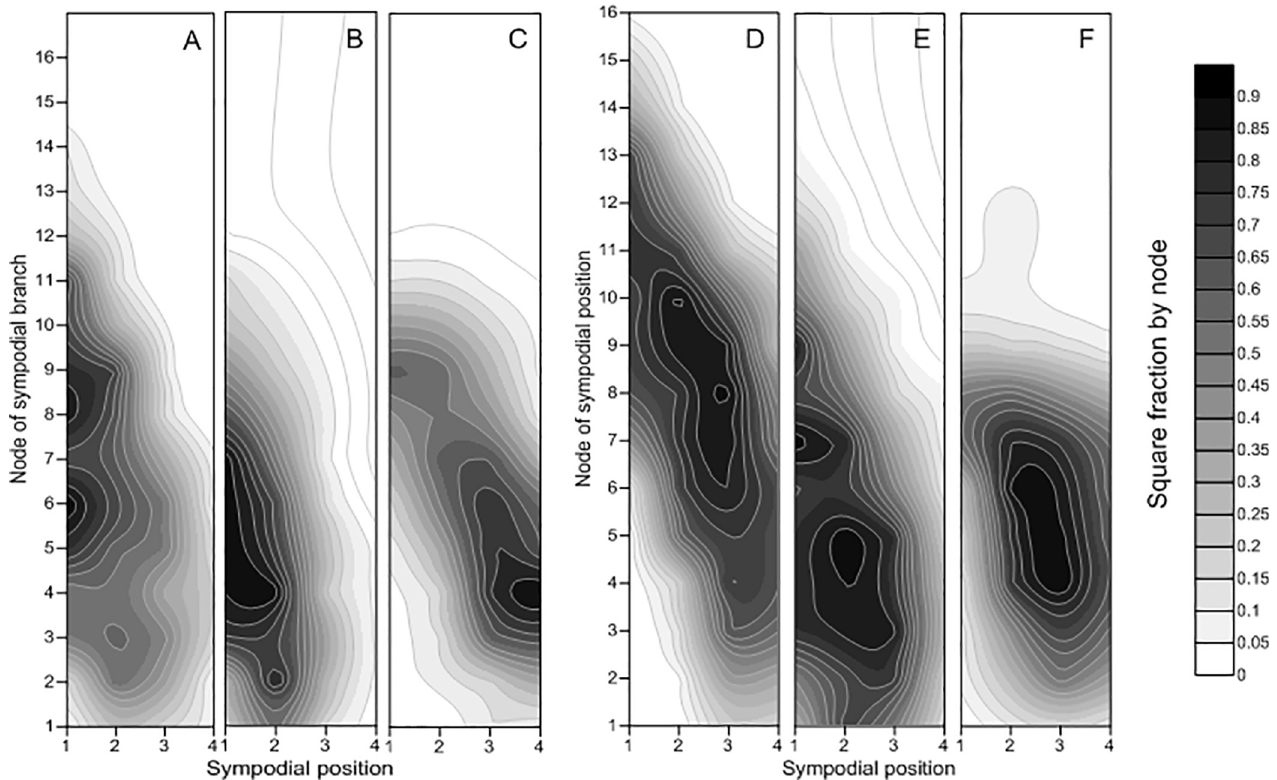
Fig 3. Fraction of squares of the different planting patterns at 75 DAS in 2016 and 2017. Note: A, B, and C represent the cotton monoculture (CM) system, the cotton/wheat intercropping (CWI) system, and the system in which cotton was directly seeded after wheat (CWD), respectively, in 2016; D, E, and F represent the cotton monoculture (CM) system, the cotton/wheat intercropping (CWI) system, and the system in which cotton was directly seeded after wheat (CWD), respectively, 2017.